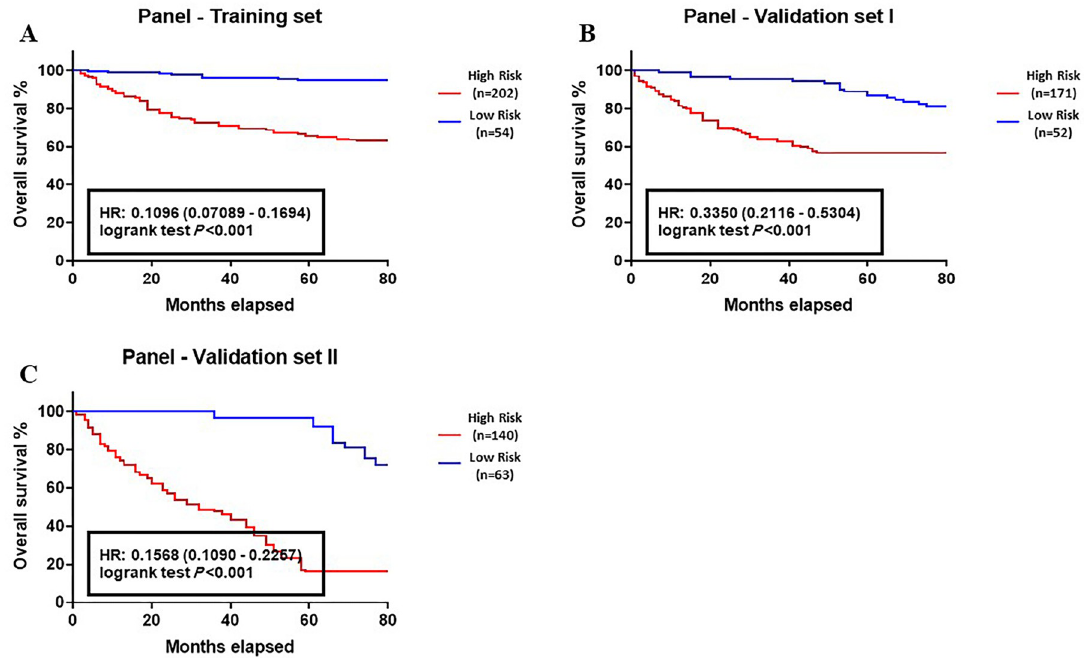
Fig 5. Correlation between the expression of lipogenic genes panel and overall survival (OS) of colon cancer patients. (A) Training group, (B) Validation group I, and (C) validation group II. OS analysis of lipogenic genes panel showed a statistical correlation between the high predicted point of genes panel and worse OS of CRC patients. (Training group (n = 257): Low risk n = 54, High risk n = 202; Validation group I (n = 223): Low risk n = 52, High risk n = 171; Validation group II (n = 203): Low risk n = 63, High risk n =